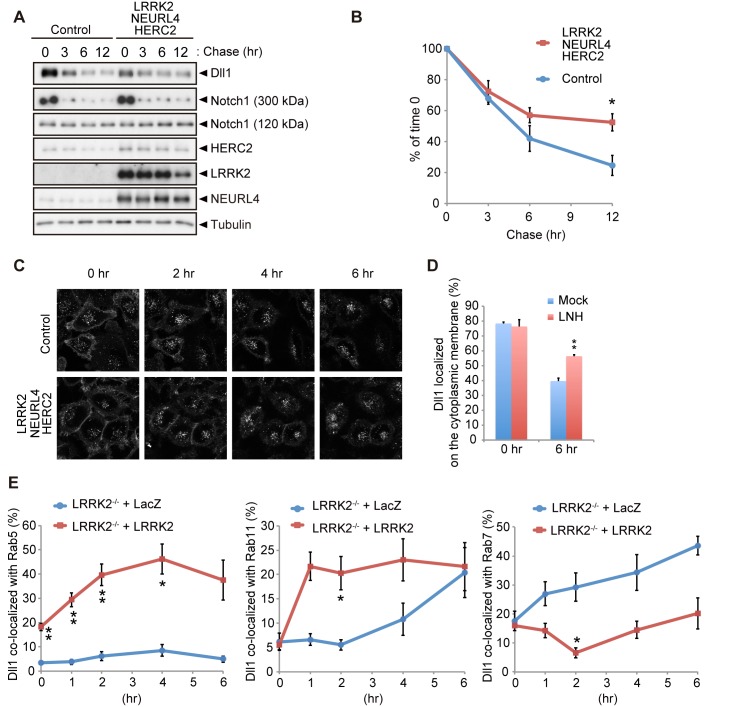
LRRK2 complex modulates Dll1 turnover in the endosomal pathway.(A) Co-expression of LRRK2, NEURL4 and HERC2 stabilizes Dll1. HeLa cells stably expressing Dll1-HA were transfected with a mixture of plasmids for LRRK2/NEURL4/HERC2 or with LacZ as a control. At 24 h after transfection, the cells were then treated with cycloheximide (CHX, 100 μg ml-1) for the indicated times, and Western blotting assays were performed. (B) The level of Dll1 remaining at different time points was plotted as the percentage of the initial Dll1 level (0 h of CHX treatment). The data are shown as the mean ± SE from four repeated experiments (*, p < 0.05 by Student’s t-test). (C) Dynamics of cell surface Dll1. HeLa cells stably expressing Dll1-SNAP were transfected as in (A). Cell surface Dll1 was labeled with SNAP-Surface Alexa Fluor 647 for 20 min at 37°C. Representative grayscale images of Dll1 labeled with Alexa Fluor 647 0–6 h after washout of the tracking dye (t = 0) are shown. (D) LRRK2 complex increases the amount of cell-surface Dll1. The data are presented as the mean ± SE for six independent experiments, with 13–26 cells counted per sample. **, p < 0.01 vs. Mock at 6 h determined by Student’s t-test. (E) LRRK2 stimulates the recycling of Dll1 via the endosomes. LRRK2-deficient mouse embryonic fibroblasts stably expressing Dll1-SNAP along with EGFP-Rab5, EGFP-Rab7 or EGFP-Rab11 were transfected with LacZ or LRRK2 and were labeled with SNAP-Surface Alexa Fluor 647 as in (C). Graph showing that Dll1 colocalized with the indicated Rab proteins (mean ± SE for 3–7 independent experiments, with 5–7 cells counted per sample). ** p < 0.01, * p < 0.05 by Student’s t-test.